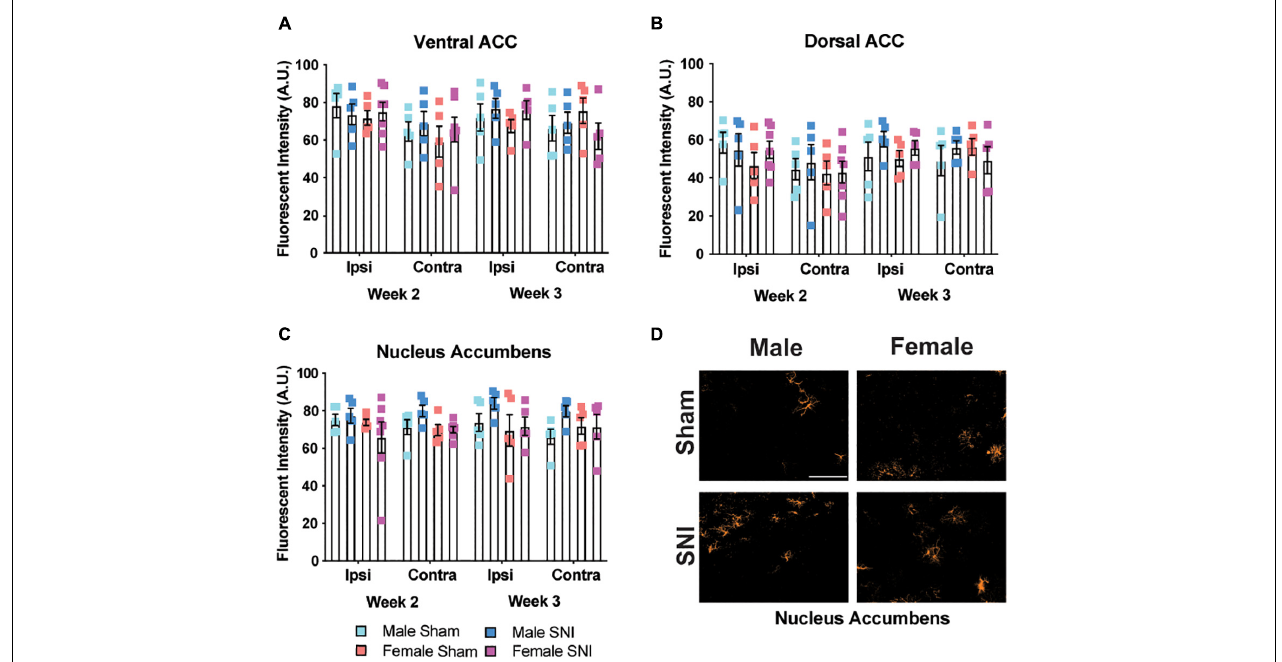
FIGURE 3 | Astrocyte changes in selected brain regions following SNI. Astrocyte expression is not changed following SNI in the (A) ventral ACC, (B) dorsal ACC, or (C) nucleus accumbens in a time and sex-dependent manner ( n = 5–6/sex/condition, three tissue samples per mouse). (D) Representative images taken from the contralateral nucleus accumbens show astrocyte expression for male and female mice at the 2-week time point. Fluorescence is presented as arbitrary